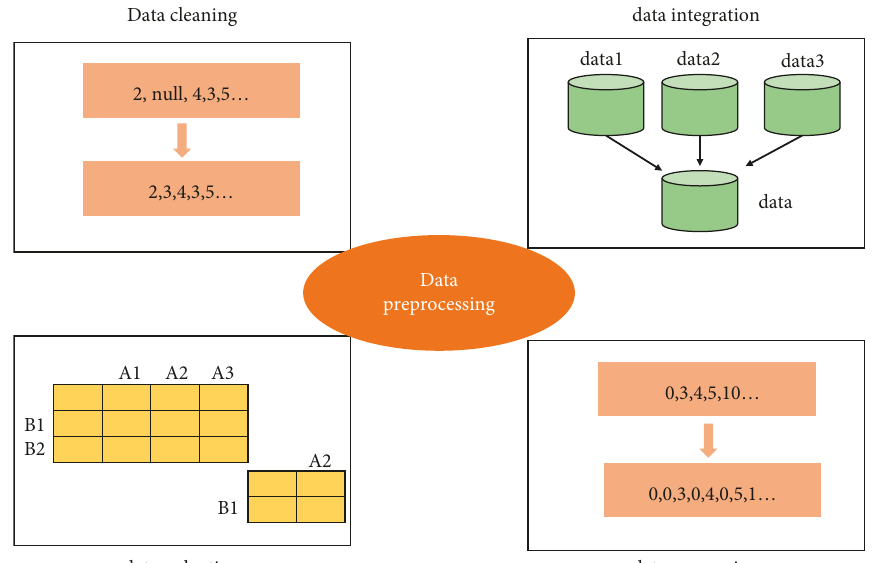
Figure 1: Data preprocessing